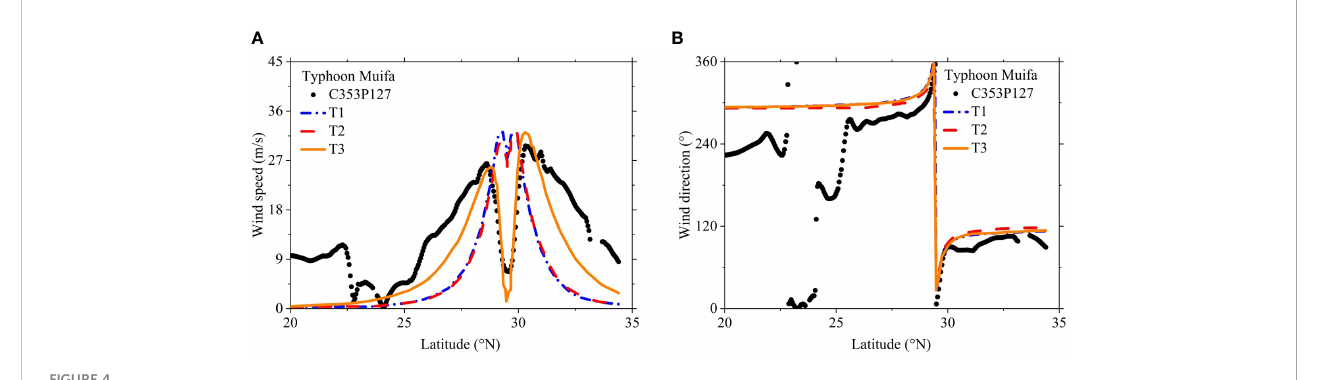
FIGURE 4 The modeled and satellite observed: (A) wind speed, (B) wind